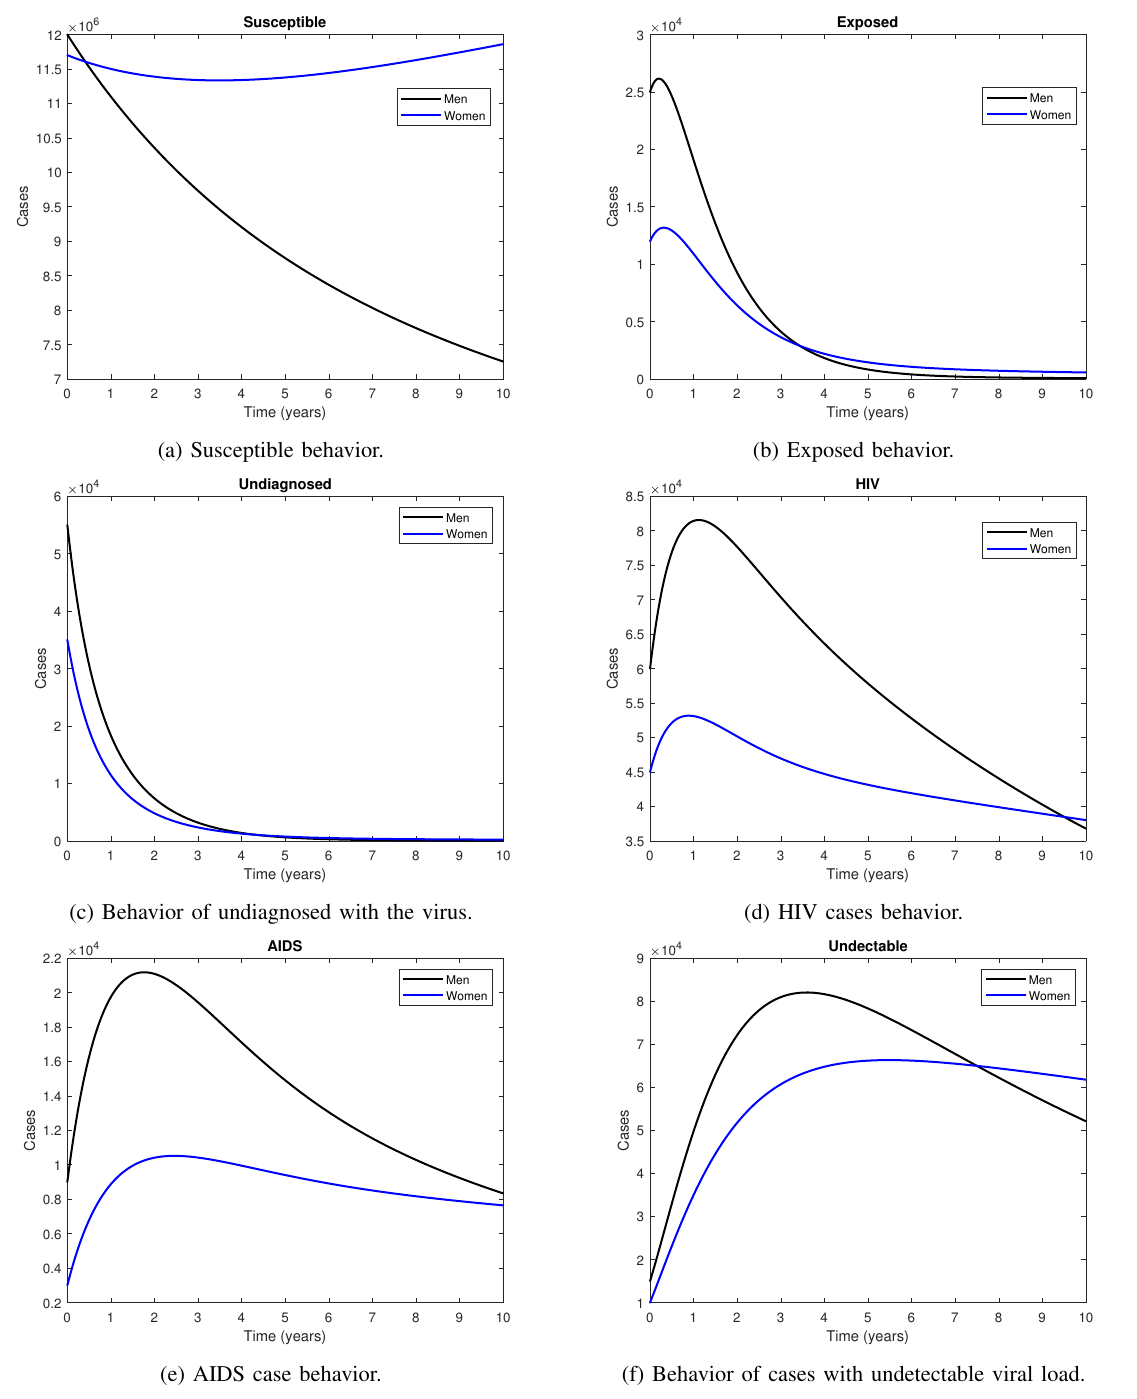
Fig. 2: Behavior of men and women compartments for the values in Tables I-II, for a 10-year study.